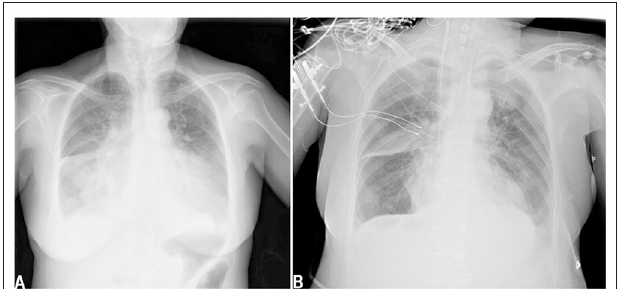
FIGURE 1 | Chest x-ray showed pulmonary oedema and bilateral pleural effusion when admission (A) . Chest x-ray showed pulmonary oedema and bilateral pleural effusion decreased after TAVR (B)